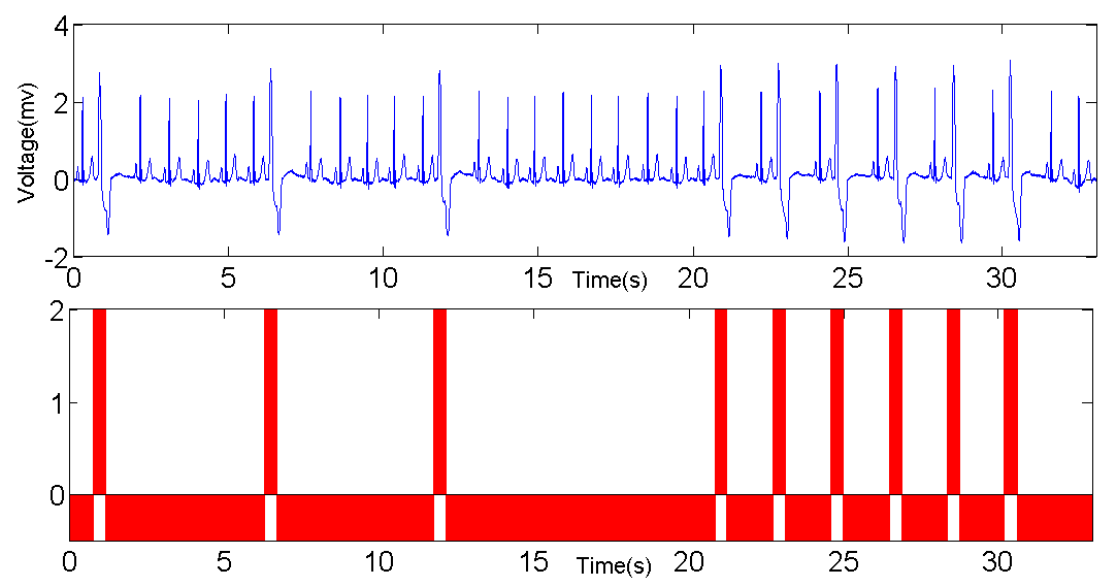
Figure 19. PVC detection based on the proposed